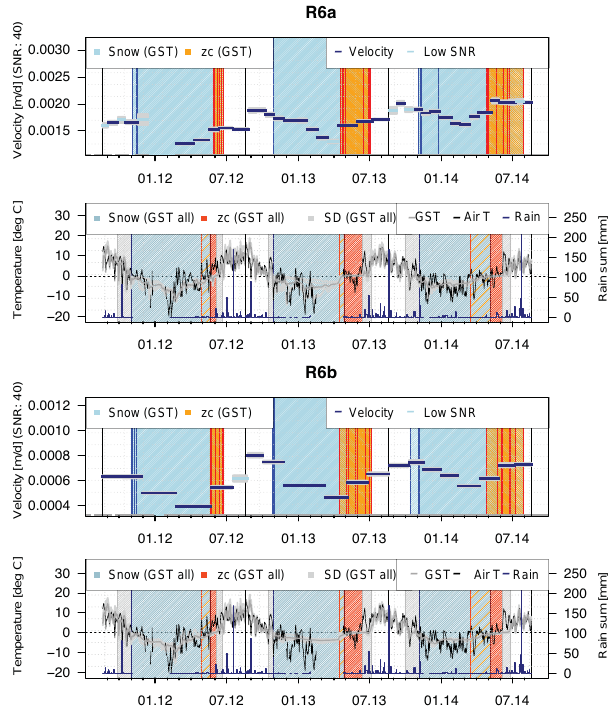
Figure 5. As Fig. 4 but for rock glacier Steintälli (R6a and b).